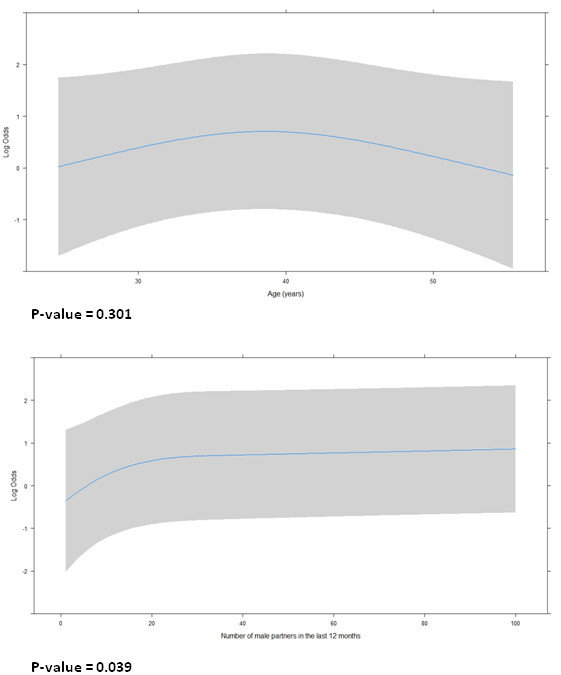
Restricted cubic spline analysis of the functional form of the association between age (years) and number of male partners in the last 12 months and the unprotected anal intercourse in the final model, IPEC/Fiocruz, 2010–2012.